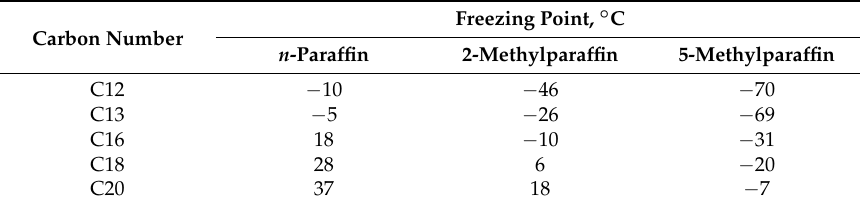
Figure 2. Schematic illustration of the effect of a hierarchical mesoporous ZSM-22 zeolite-based catalyst on hydroisomerization selectivity. Table 6. Freezing points of some normal and isomethyl paraffins of various carbon numbers (modified from Reference